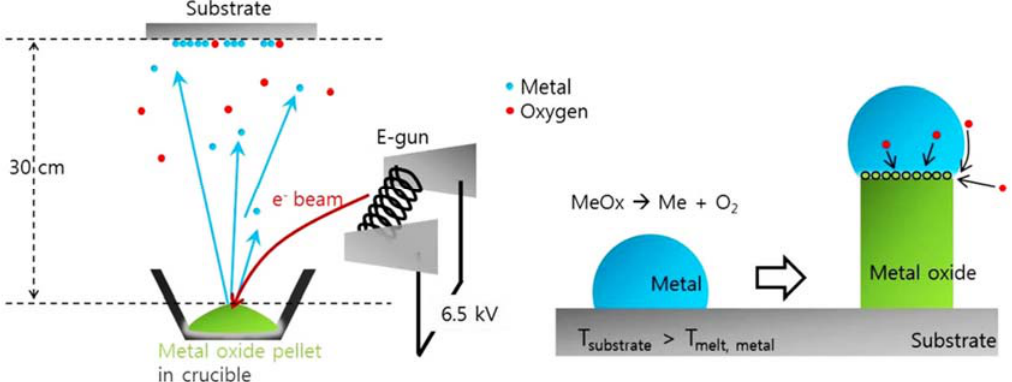
Figure 2. Diagrams of the E-beam evaporation model for the growth of metal oxide nanowire and growth process by vapor-liquid-solid [48].